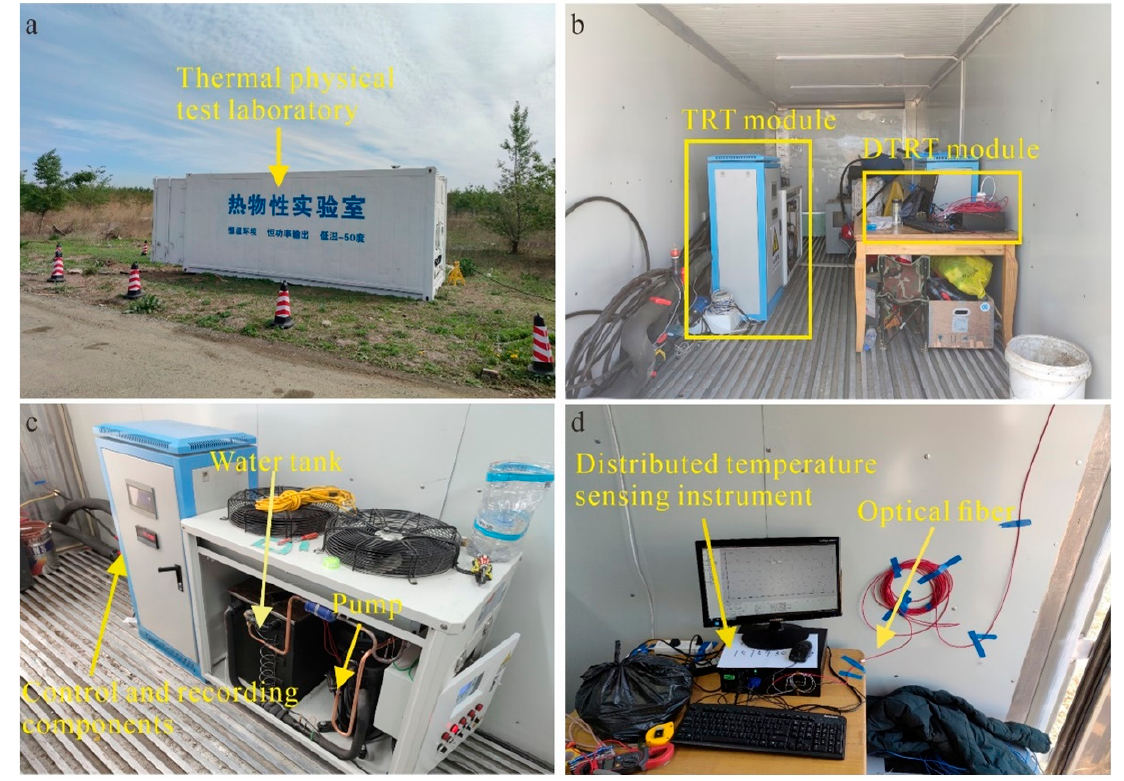
Figure 3. Field thermal response test system. ( a ) Field testing laboratory. ( b ) Inside the laboratory. ( c ) TRT module. ( d ) DTRT module. Table 1. Main technical parameters of the DOFTS.